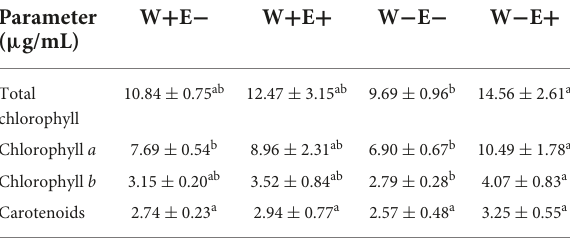
TABLE 3 Chlorophylls and carotenoid content of strawberry plants.